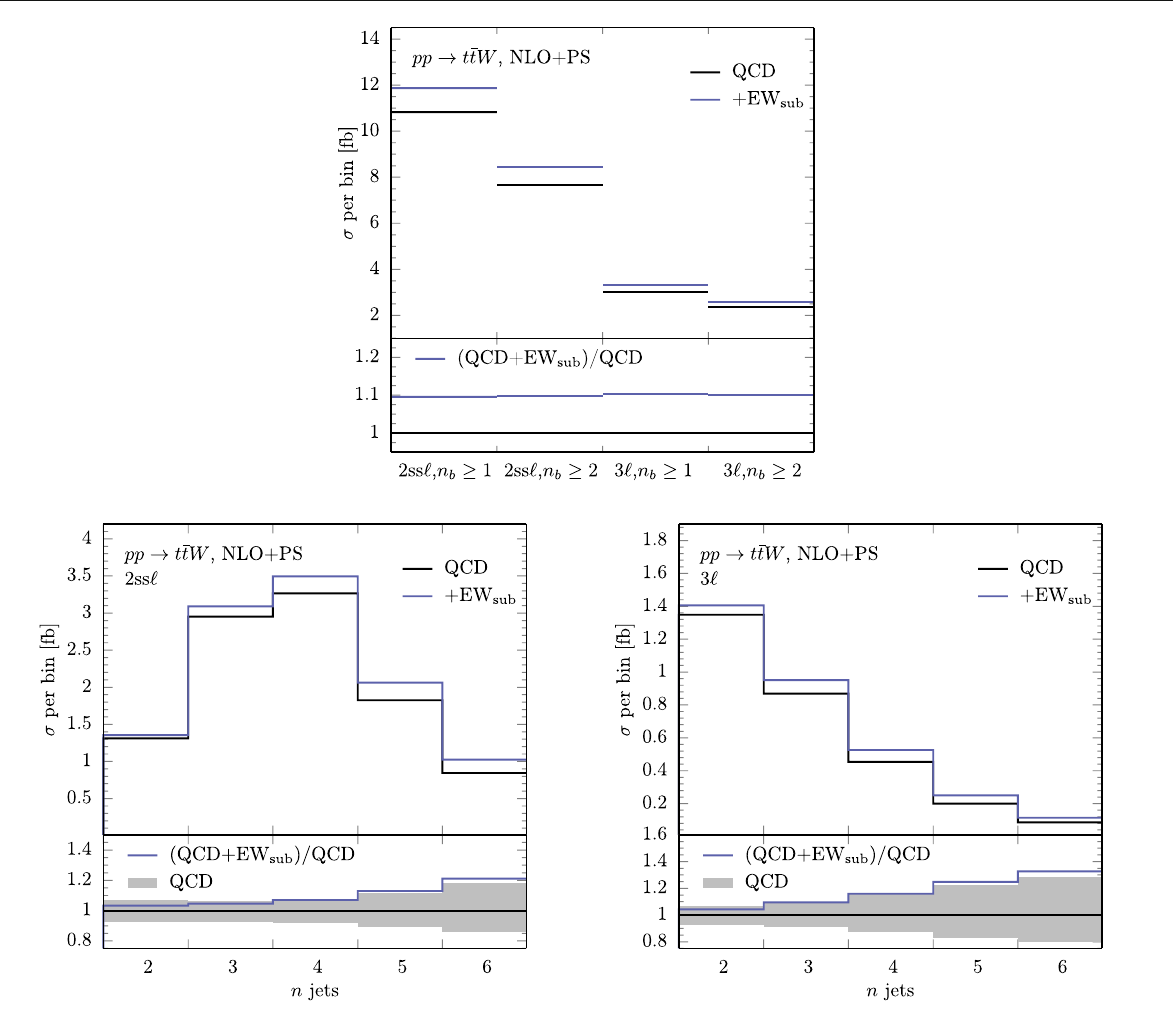
of the EW sub contributions to the total cross section and the jet multiplicities within the selected